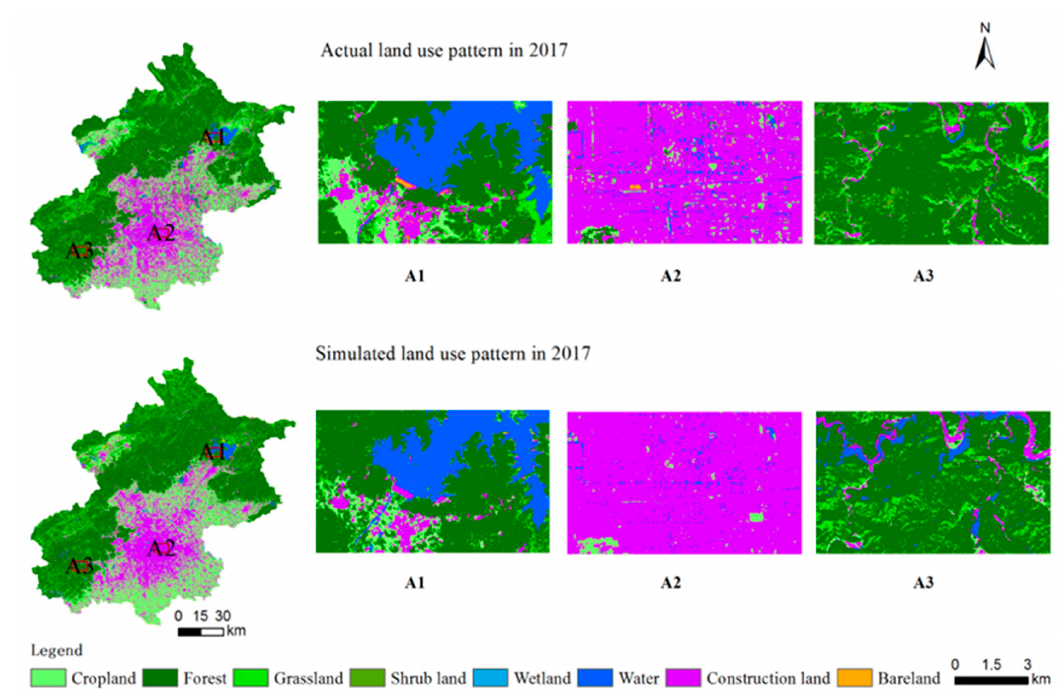
Figure 7. Comparison of actual and simulated landscape patterns in Beijing for 2017.